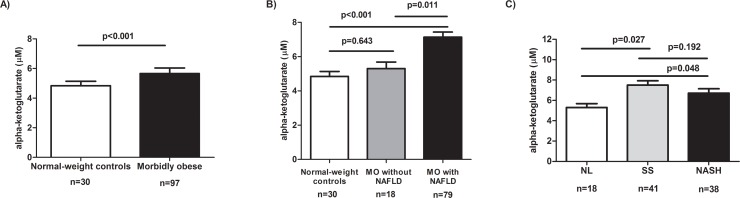
Circulating levels of alpha-ketoglutarate in study cohort.Circulating levels of alpha-ketoglutarate in normal-weight controls and morbidly obese women (A); in normal-weight controls, morbidly obese women (MO) without non-alcoholic fatty disease (NAFLD) and morbidly obese women (MO) with NAFLD (B); and in morbidly obese women according to the liver pathology (C). NL, morbidly obese women with normal liver; SS, morbidly obese women with simple steatosis; NASH, morbidly obese women with steatohepatitis. Results are shown as mean ± SD. p< 0.05 are considered statistically significant.